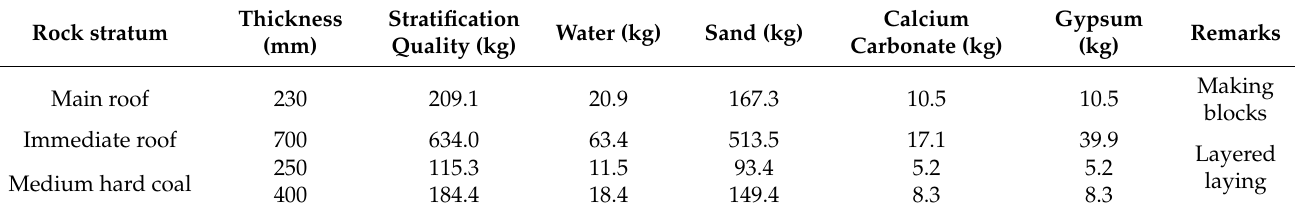
Table 3. Material ratio of physical model.